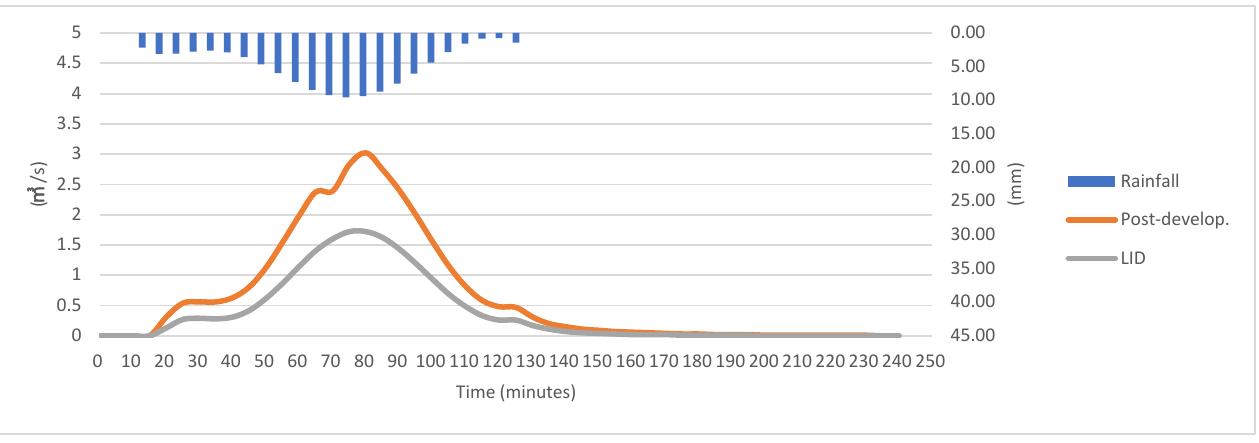
Figure 10. Hydrograph (2 h duration, 30-year design precipitation).